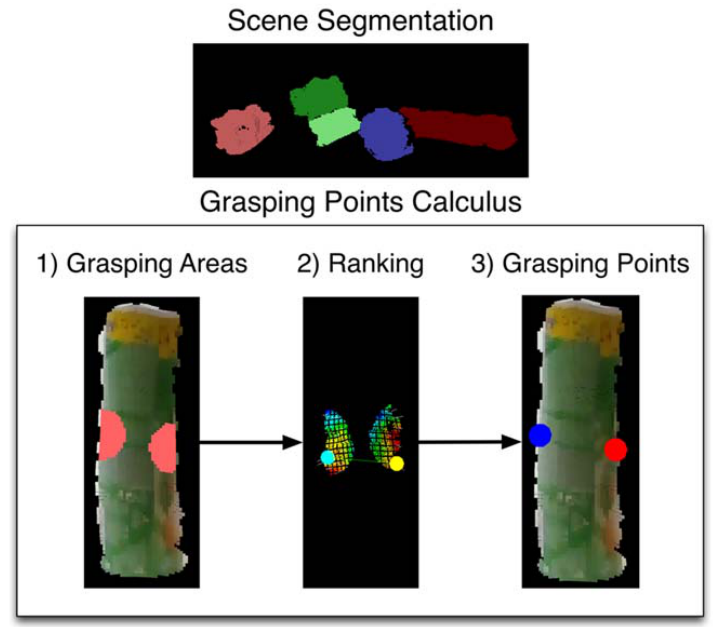
Figure 4. Steps of the method for calculating a pair of contact points. Scene Segmentation: clouds of the detected objects. Grasping Points Calculus, executed for each detected object: (1) grasping areas with potential contact points, (2) curvature values and a pair of evaluated contact points, (3) best ranked pair of contact points.